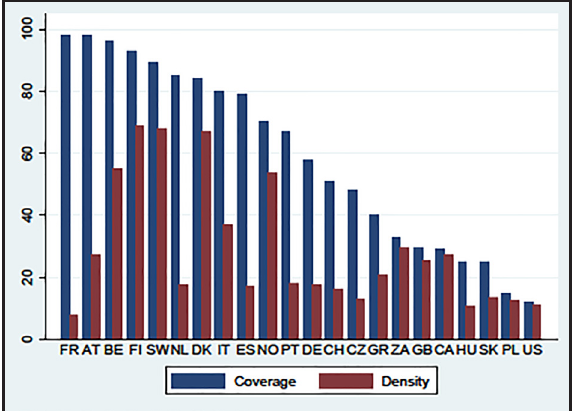
Figure 1 Collective bargaining coverage and trade union density.